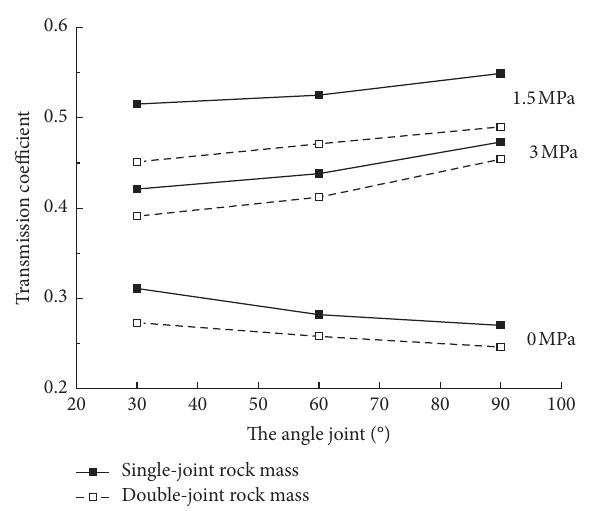
Figure 23: Effect of the number and angle of joints on transmission coefficient.